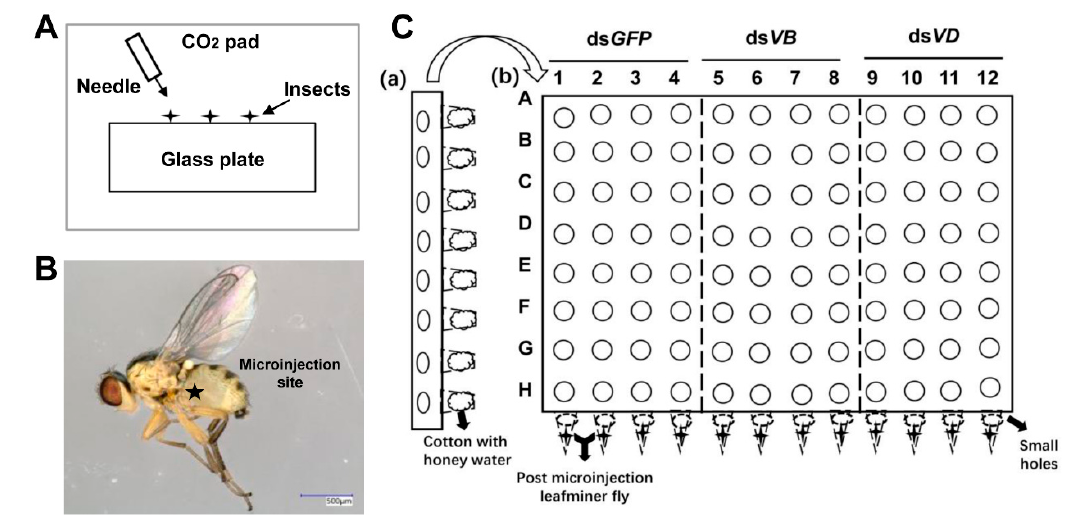
Figure 1. Schematic diagram of the microinjection method ( A ), injection site ( B ), and post-injection feeding device ( C ) used in this study. dsGFP: dsRNA of green fluorescent protein gene, dsVB: dsRNA of vacuolar-ATPase B gene, dsVD: dsRNA of vacuolar-ATPase D gene.